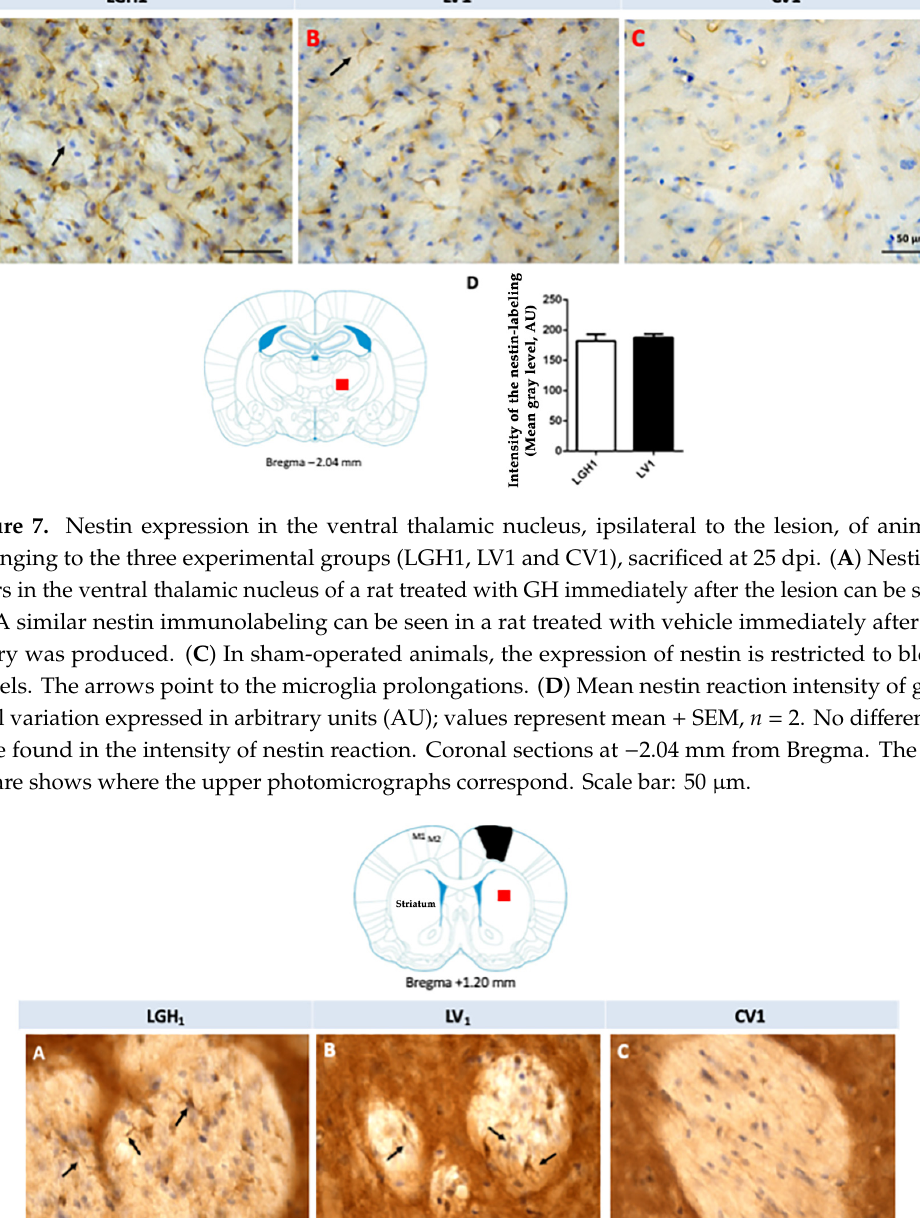
Figure 8. Actin immunoreactivity in the striatal white matter, ipsilateral to the lesion. Fine fibers, actin + , were observed in a rat treated with GH ( A ) or vehicle ( B ). However, no actin immunostaining was found in sham-operated control animals ( C ). Arrows point to actin + fibers. Coronal sections at + 1.20 mm from Bregma. The red square indicates where the images were taken. The black trapezoid indicates where the ablation of the motor frontal cortex was done. Scale bar = 50 µ